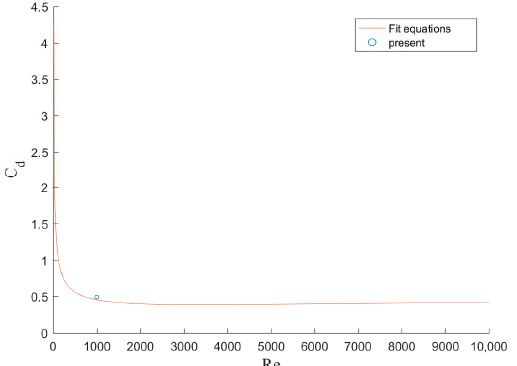
Figure 27. Comparing the drag coefficient 𝐶 (cid:3005) with the fitting equation [52] at Re = 1000.